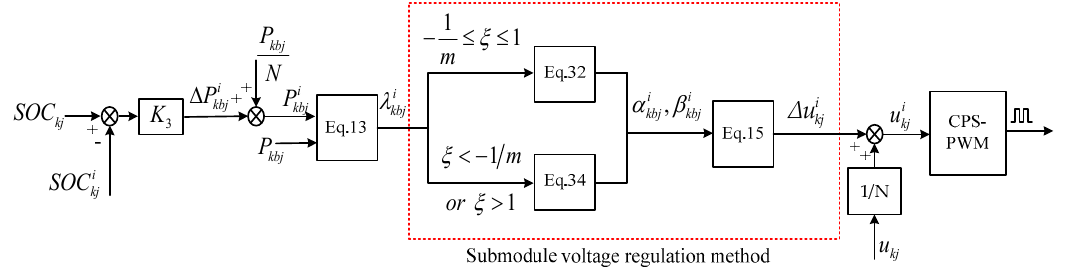
Figure 6. Modified SOC balancing control within arms.